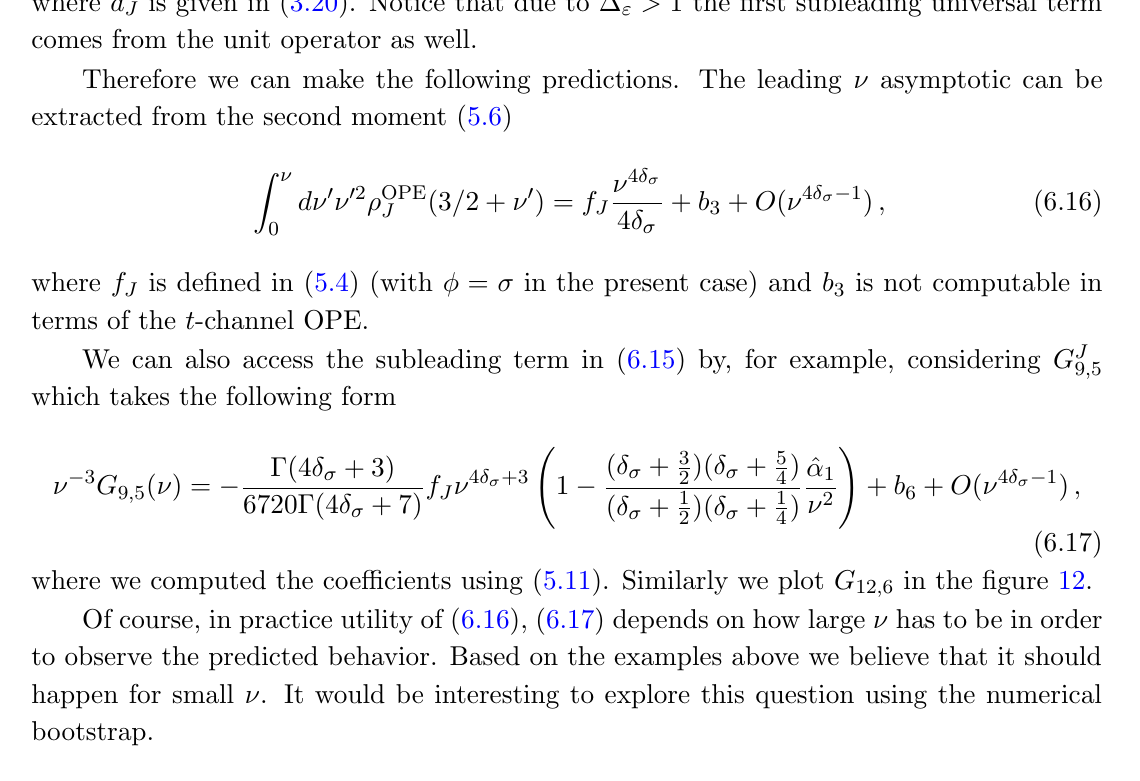
Figure 12 . G 12 ; 6 in the 2d Ising model. We subtract (cid:23) 9 = 2 and (cid:23) 5 = 2 terms 1 the sub-sub-leading (cid:23) 1 = 2 term. We expect the di(cid:11)erence to go to a constant which we (cid:12)t to be b 7 (cid:25) 1 : 28 (cid:2) 10 (cid:0) 5 . Again, we get a perfect agreement with the prediction.